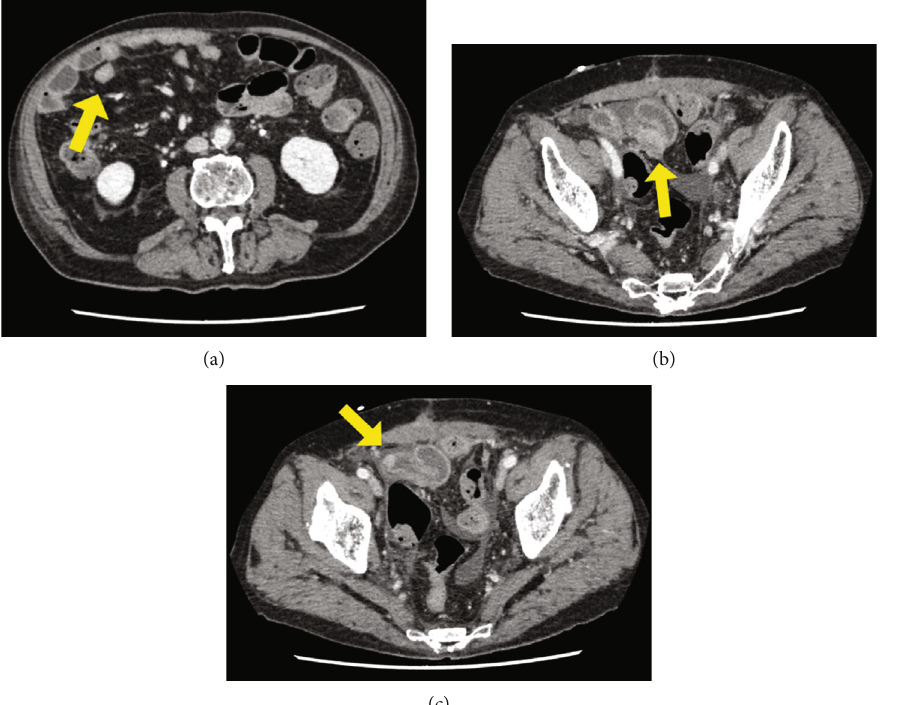
Figure 5: A postoperative contrast-enhanced abdominal computed tomography (CT) scan showed enlargement of one of the peritoneal nodules (a, arrow) and the invasion of nodules with edematous lumens to the small intestine (arrows) (b,